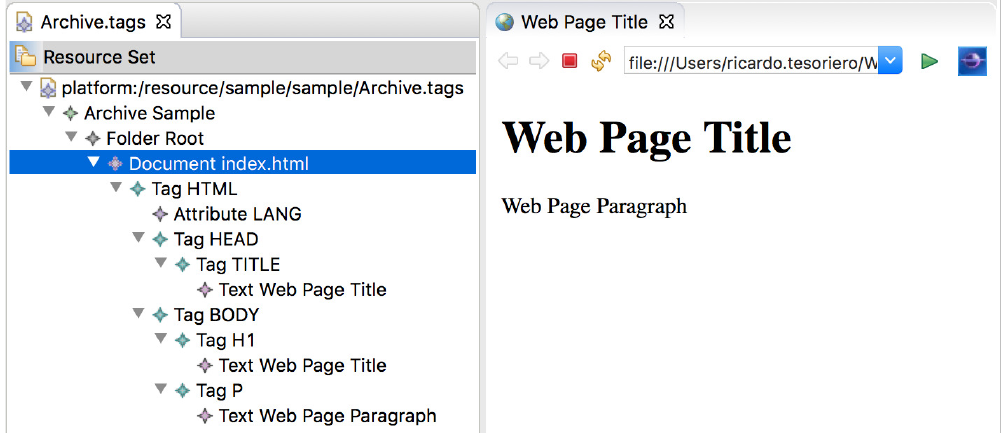
Figure 5. Example of the TagML model of a Web